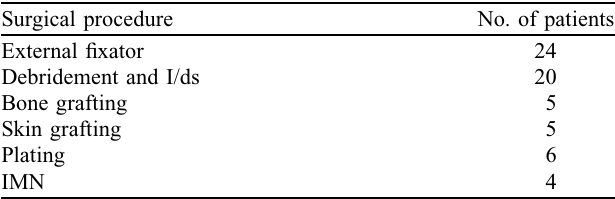
Table 1. Different surgeries done prior to applying